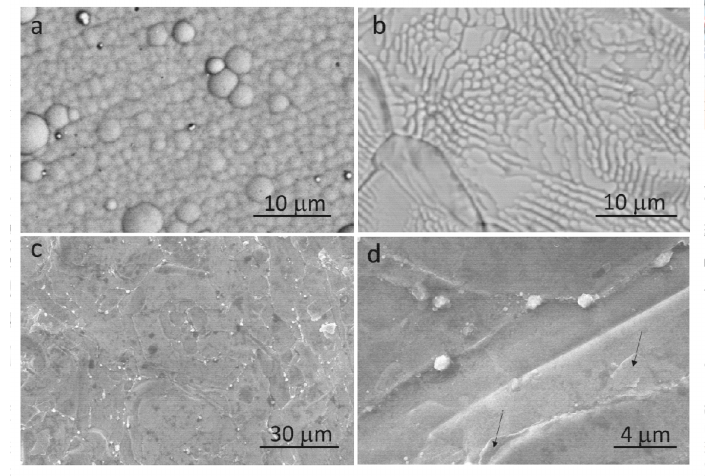
Figure 1. SEM images of Ni–P ( a ), Ni–P–H ( b ), Ni–P–G ( c ), and enlarged view of Ni–P–G ( d